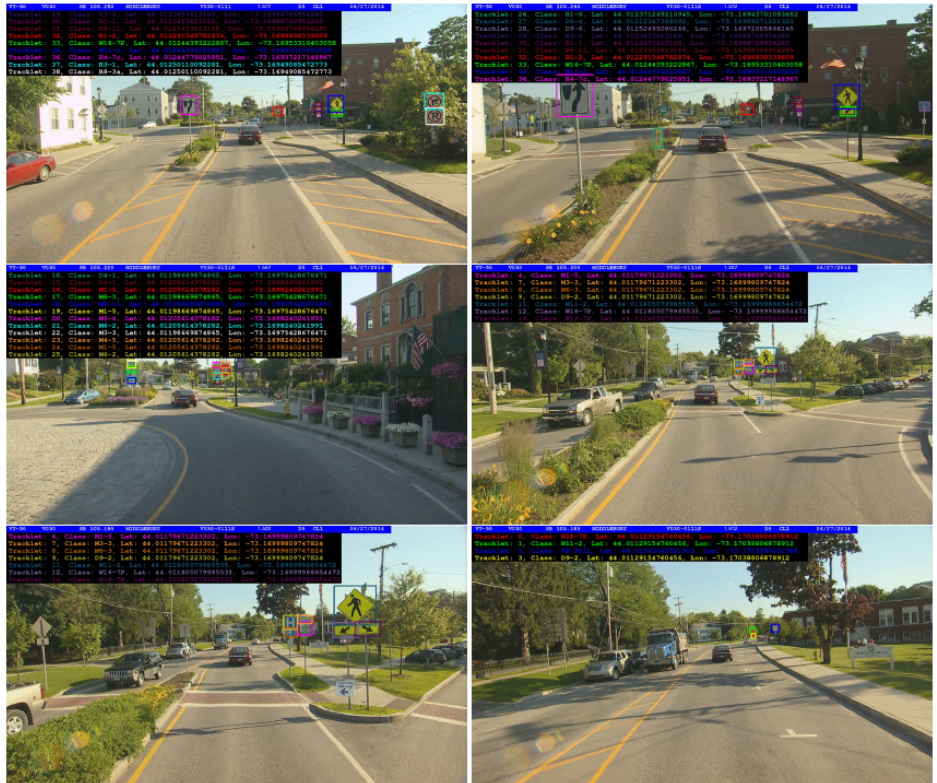
Figure 8. Sample images and detections from the ARTSv2 datset. Images contain a variety of sign types, often clustered very close together, which makes for challenging geo-localization. Each box around each sign represents a separate detection from GPS-RetinaNet. The color of the box represents which tracklet the detection has been assigned to by the multi-object tracker. Since a tracklet is a list of signs predicted to be the same, re-occurrences of the same sign in multiple images should have the same color box around